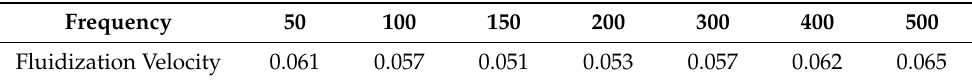
Table 4. The relation table of minimum fluidization speed and frequency.